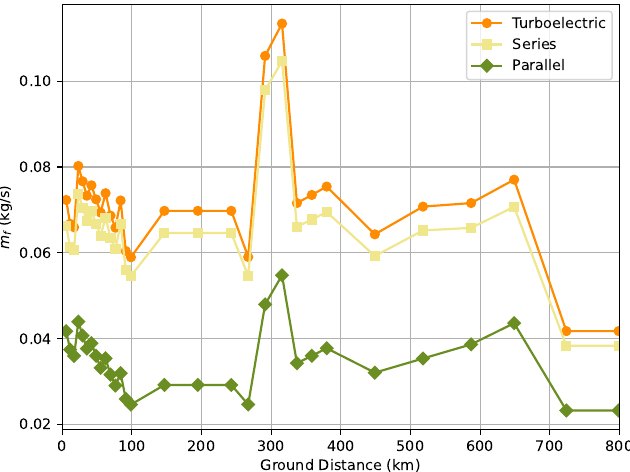
Figure 13. Comparison of the fuel flow required between the two configurations. Even though the same combustion engine model, tuned for the validation test case, was used for all the propulsion systems, different power requirements are noticeable